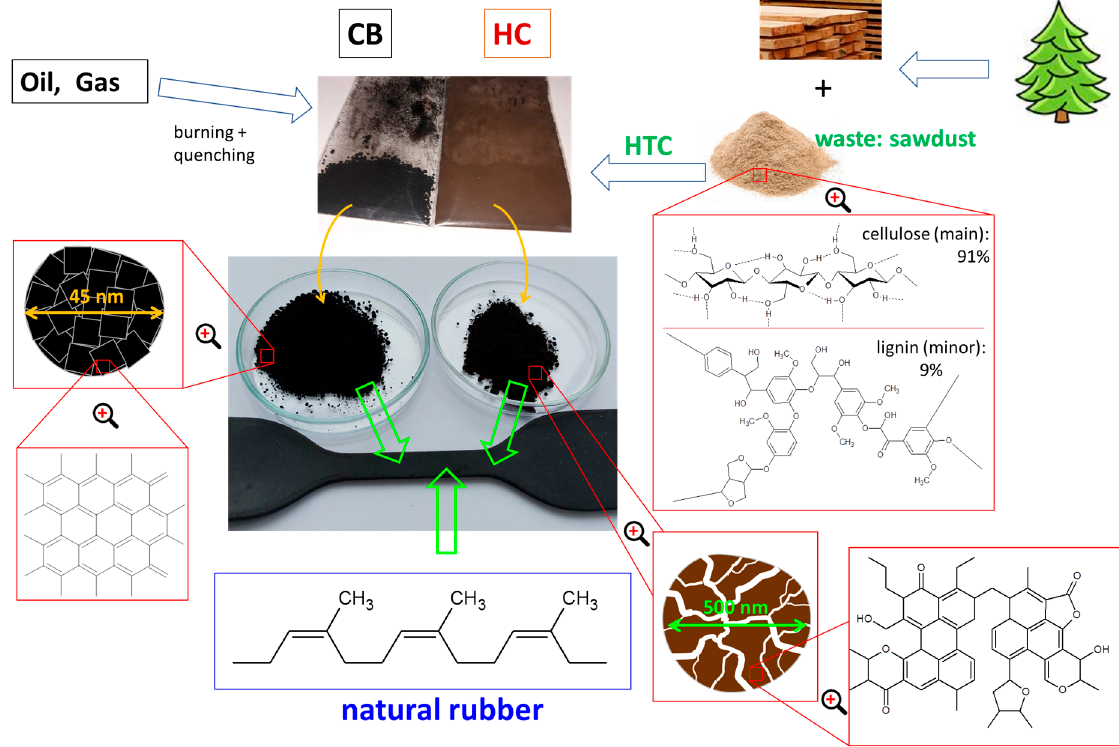
Scheme 1. Preparation and structure of carbon black and hydrochar, used as fillers in natural rubber